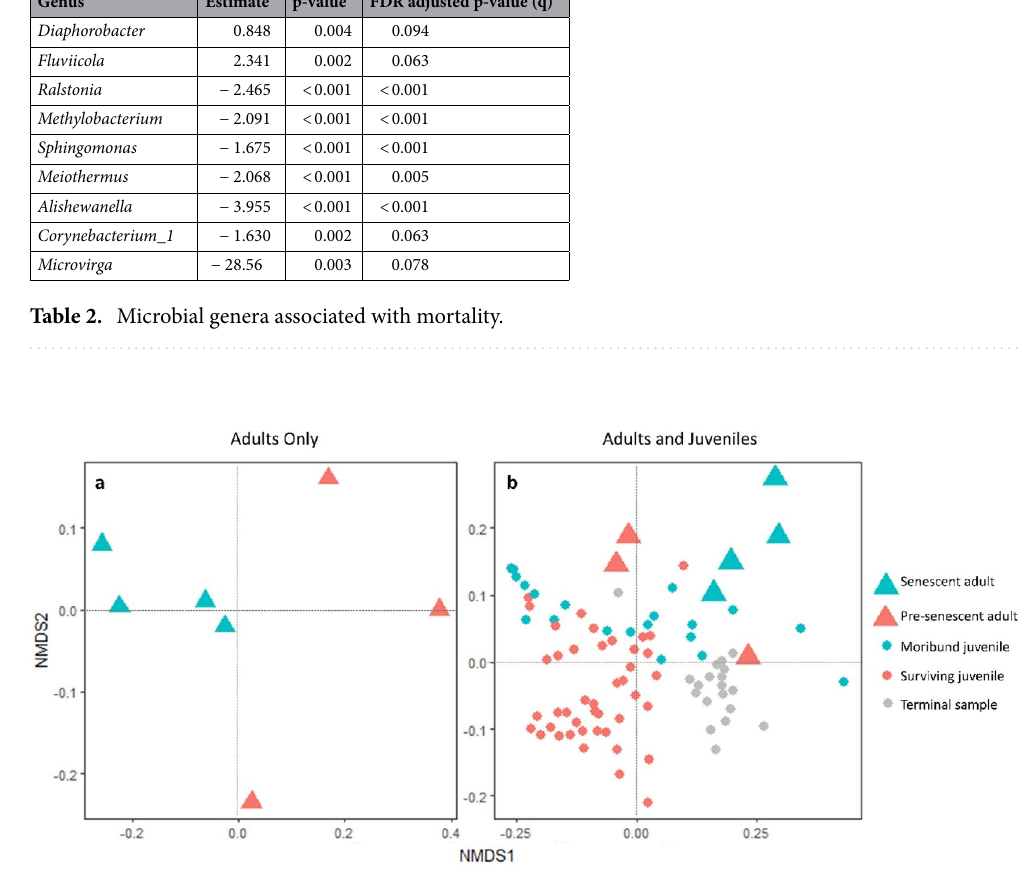
Figure 4. Nonmetric multidimensional scaling of weighted unifrac distances among adults and juveniles. ( a ) Beta diversity differed between early senescence and late senescence adults. ( b ) Adults in all stages of senescence appear more similar to moribund juveniles than surviving